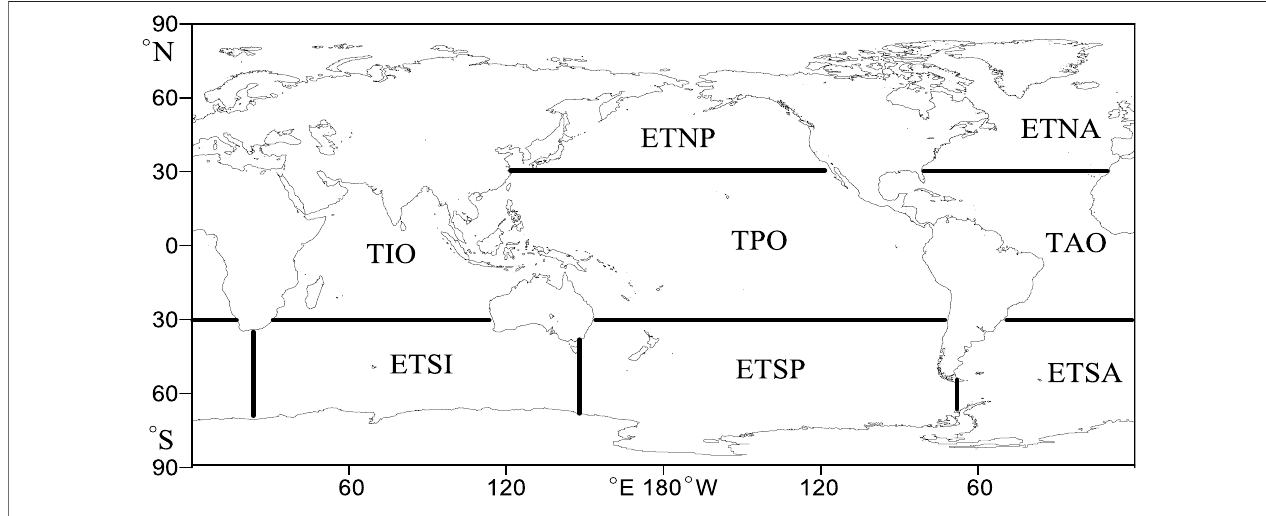
FIGURE 9 | Key areas: tropical Indian Ocean (TIO), extratropical south Indian (ETSI), extratropical North Paci fi c (ETNP), tropical Paci fi c Ocean (TPO), extratropical South Paci fi c (ETSP), extratropical north Atlantic (ETNA), tropical Atlantic Ocean (TAO), and extratropical South Atlantic (ETSA).